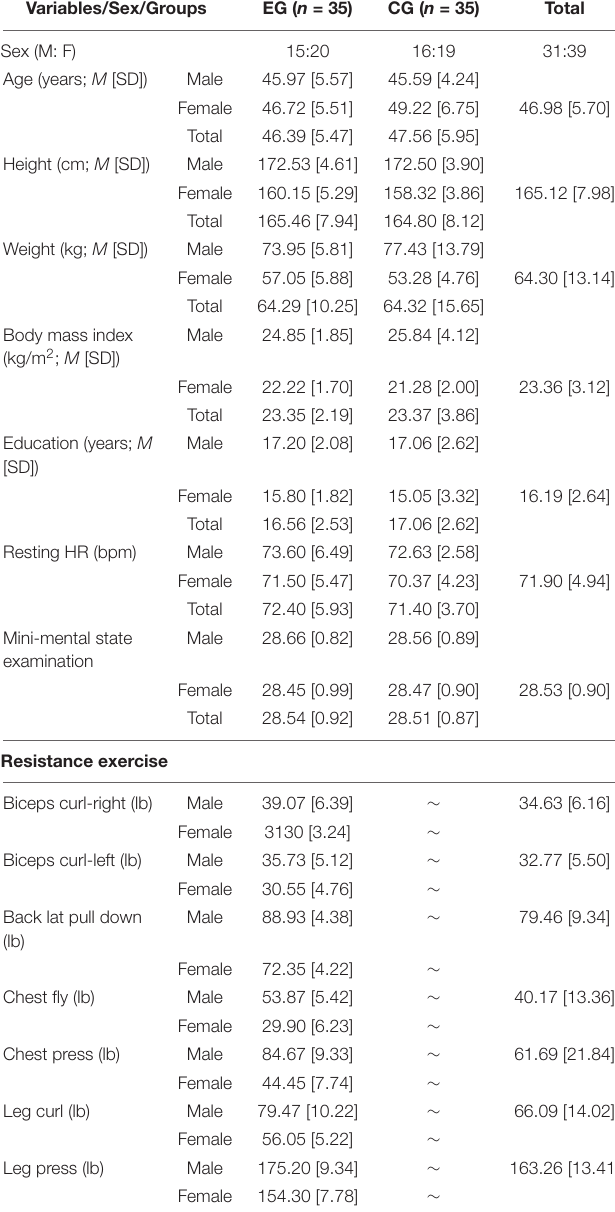
TABLE 1 | Summary of the demographic characteristics of the participants.